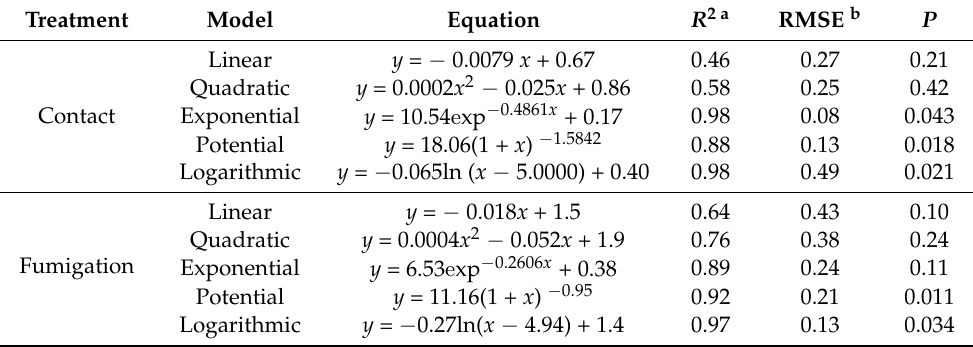
Table 4. Mathematical-model fitting for safrole residues in cowpea beans treated with Piper hispidin- ervum essential oil, either by contact (a) or fumigation (b), throughout storage.